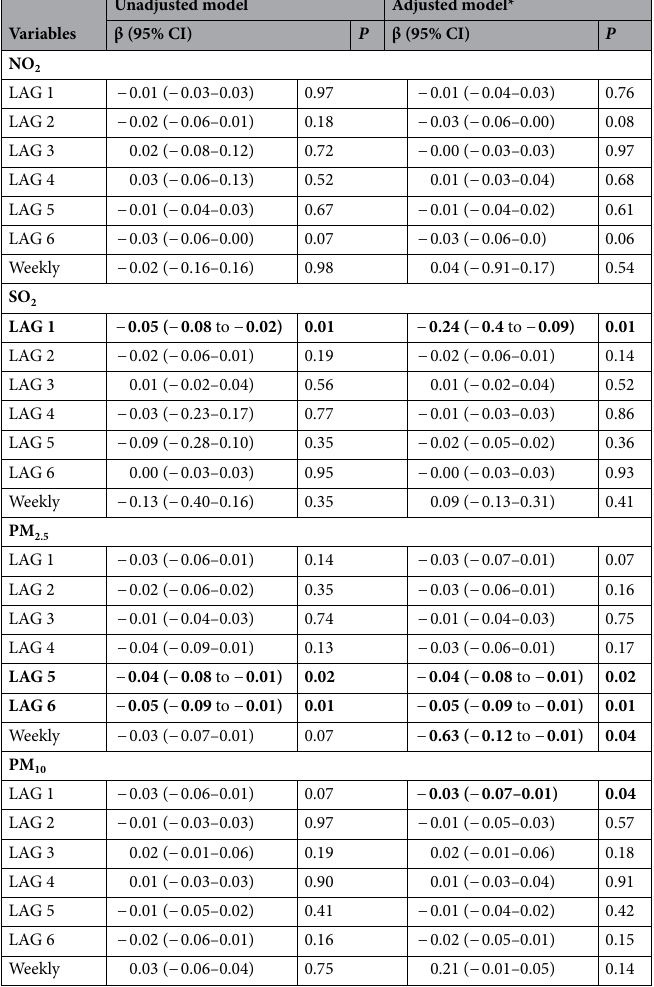
Table 6. Linear regression model. Estimated associations of increase of air pollution and glomerular filtration rate. *Model was adjusted for age, sex, clinical variables including obesity, atrial fibrillation, hyperlipidemia, diabetes mellitus and arterial hypertension. The lag-model for each day was estimated separately. Abbreviations : CI, confidence interval; NO 2 , nitrogen dioxide; PM 2.5 , particulate matter with a diameter of 2.5 μm or less; PM 10 , particulate matter with a diameter of 10 μm or less; SO 2 , sulfur